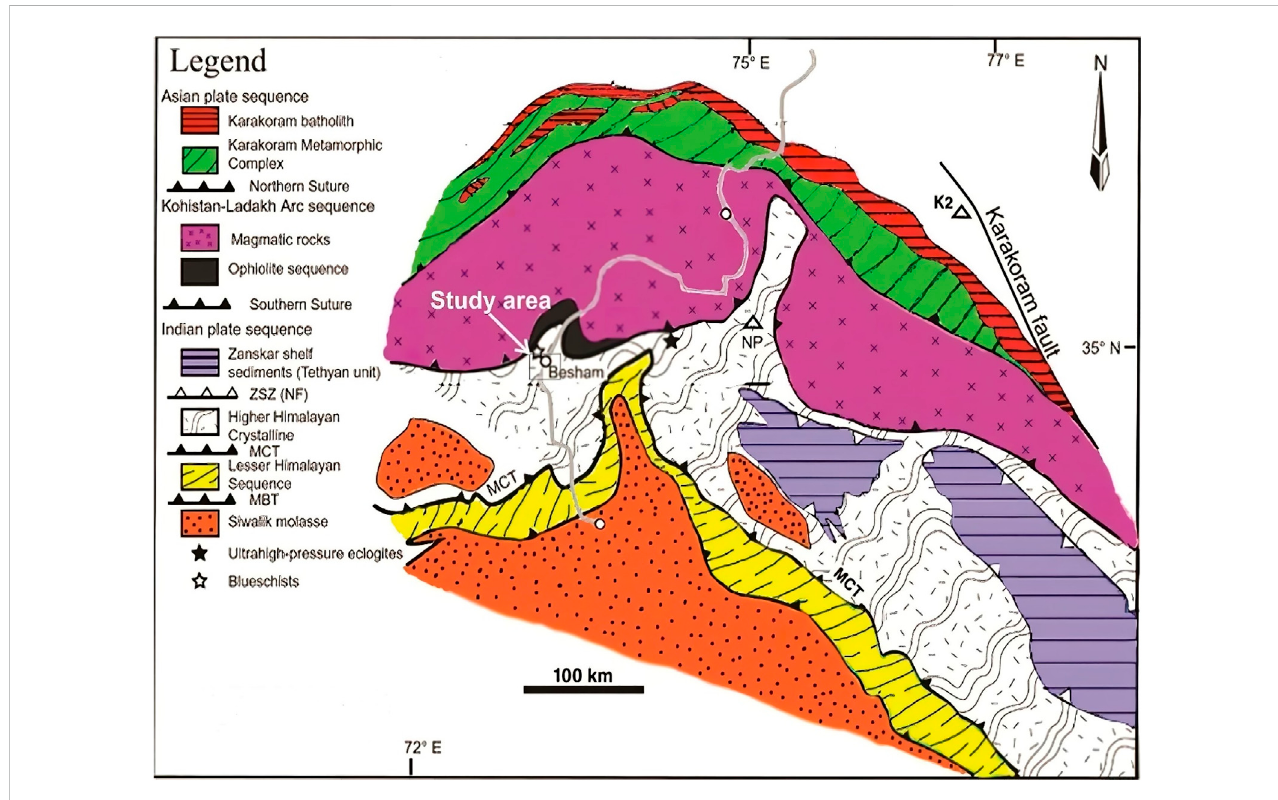
FIGURE 1 Regional geological map of the Northwest Himalaya showing major tectonic units of the Indian Plate, rocks of the Kohistan – Ladakh arc sequence, and the southern margin of the Asian Plate. Modi fi ed after Rehman et al.